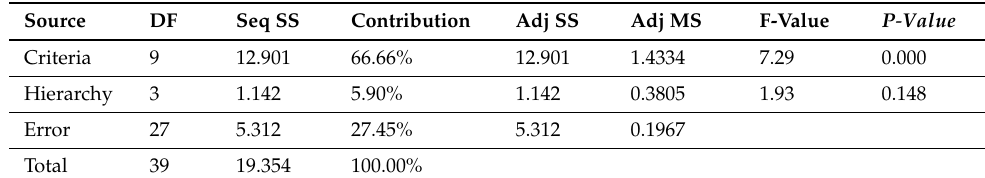
Table 5. Two-way ANOVA: Criteria and hierarchy.